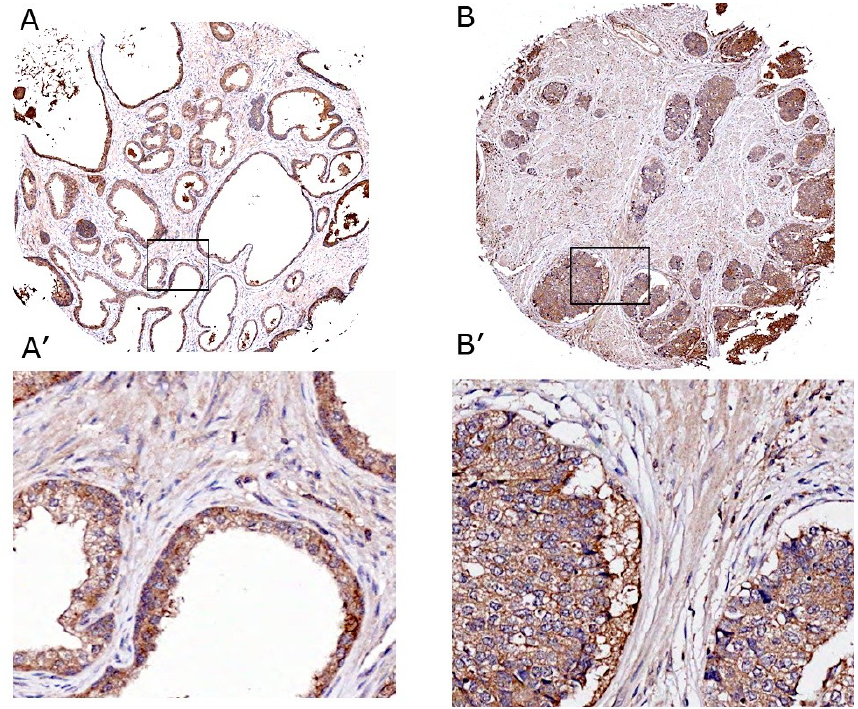
Figure S3. Immunohistochemistry on tissue microarray sections containing normal tissue adjacent to adenocarcinoma and adenocarcinoma at grades 1 to 3. Immunohistochemical staining was performed with an antibody to osteopontin. Normal tissue adjacent to prostate cancer ( A ) and adenocarcinoma at grade 2–3 ( B ) are shown. Sections were immunostained (brown) as described in the Methods section. Immunostained sections were counterstained with hematoxylin stain (blue). Location of the high magnification regions are shown by a rectangle field in ( A ) and ( B ) Magnification is 50× in A and B and 200× in ( A' ) and ( B' ). The staining was repeated two times with similar results. Staining was observed in stromal cells, normal prostatic tissue, and adenocarcinoma in lumen. Cytosolic staining was observed in these cells. Adenocarcinoma at grade 2–3 is shown in ( B ) and ( B' ). Prostatic adenocarcinoma sections showed multiple small foci of tumor cells. Cells appear slightly different than normal. One of the foci is showed in higher magnification ( A' and B' ). An increase in number of cells in the foci of adenocarcinoma corresponds with intense staining of cells ( B' ). A part of the reason for more OPN in the lysates from tumor tissue (Figure 1 in the main document) may be due to an increase in the number of cancer cells in the foci which express more